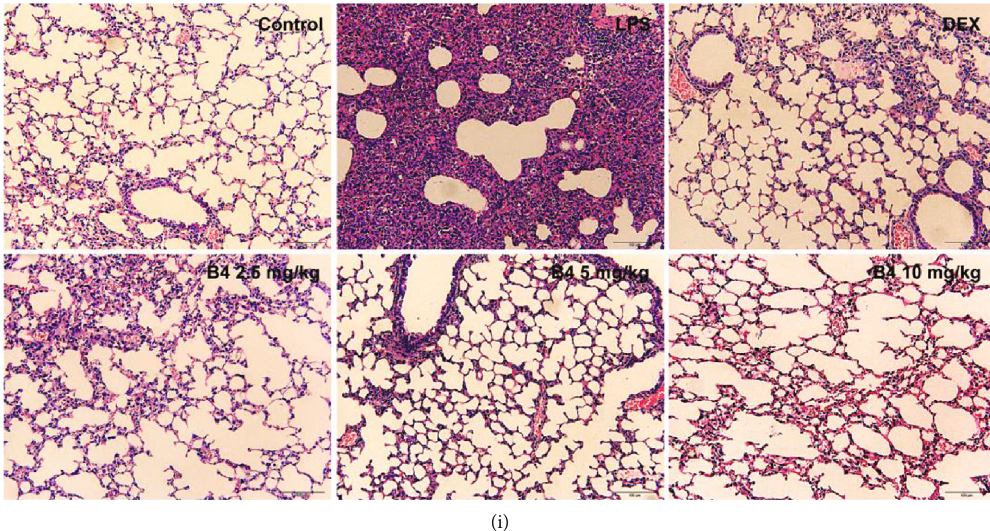
Figure 5: B4 rescued LPS-induced septic death and prevented LPS-induced ALI in mice. (a) Mice of experiment groups were treated with LPS (15 mg/kg, i.t.), and the B4-treated groups were injected with B4 (2.5, 5, and 10mg/kg, i.v.) at 0, 3, 24, 48, and72h after LPS administration. DEX group mice were injected with DEX (5 mg/kg, i.p.) after LPS treatment. The survival rate was recorded for the next 144 h ( n = 20 ). (b – d) The mice were treated with LPS (4 mg/kg, i.t.). After LPS injection, mice were treated with B4 at 0, 3, 24, 48, and 72 h. After 72 h, blood samples were collected. Blood lymphocytes, neutrophils, and WBC were examined by the blood analyzer ( n = 20 ). (e – g) The in fl ammatory cytokines TNF- α , IL-6, and IL-1 β in serum were detected by ELISA ( n = 10 ). (h) The MPO level in lung tissues was detected by MPO kit ( n = 10 ). (i) H&E staining of the lung tissue (H&E, original magni fi cation, 200x). DEX (5 mg/kg, i.p.) was used as a positive control ( n = 10 ). ∗ P < 0 : 05 , ∗∗ P < 0 : 01 , and ∗∗∗ P < 0 : 001 , compared to LPS-alone